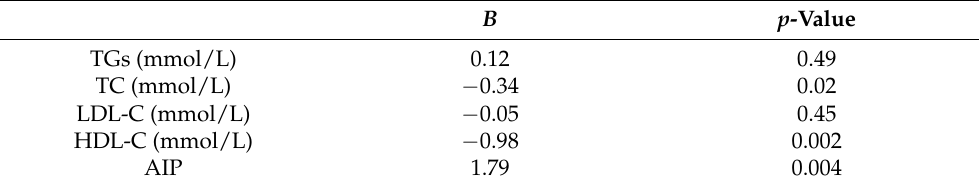
Table 4. The relationship between lipidic fractions and OSA in subjects undergoing diagnostic PSG. B p -Value TGs (mmol/L) 0.12 0.49 TC (mmol/L) − 0.34 0.02 LDL-C (mmol/L) − 0.05 0.45 HDL-C (mmol/L) − 0.98 0.002 AIP 1.79